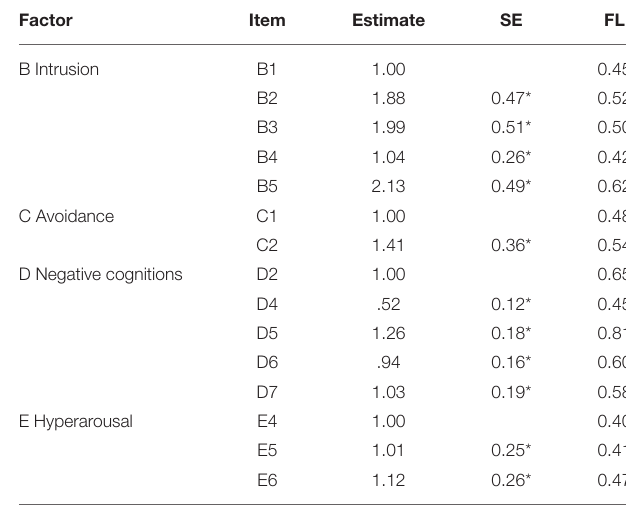
TABLE 4 | Parameter estimates for the 15-item CAPS-5 model.